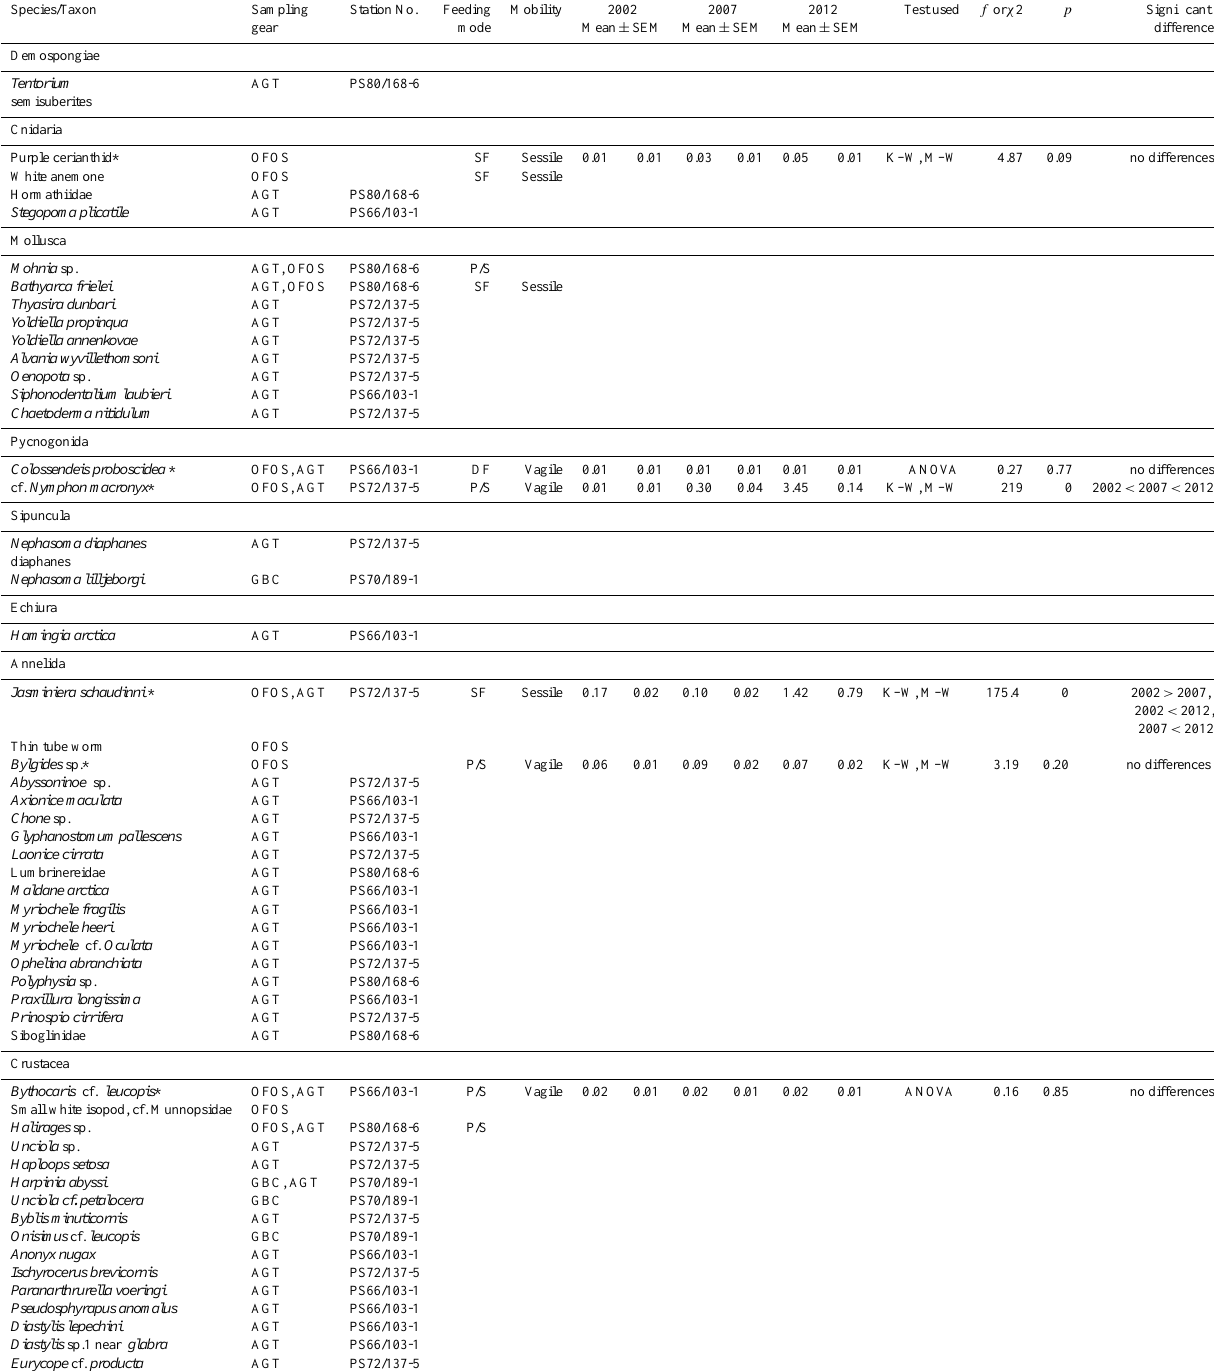
Table 2. Mean densities (ind.m − 2 ) of megafaunal taxa recorded from images in 2002, 2007, and 2012 at HG I. The presence of other species collected from bottom samples is indicated (no numbers given). Asterisk denotes the 11 taxa which were reliably recognized and were used in statistical analyses. Abbreviations as in Table 1, plus the following: (SF) suspension feeder, (P/S) predator/scavenger, (DF) deposit feeder.